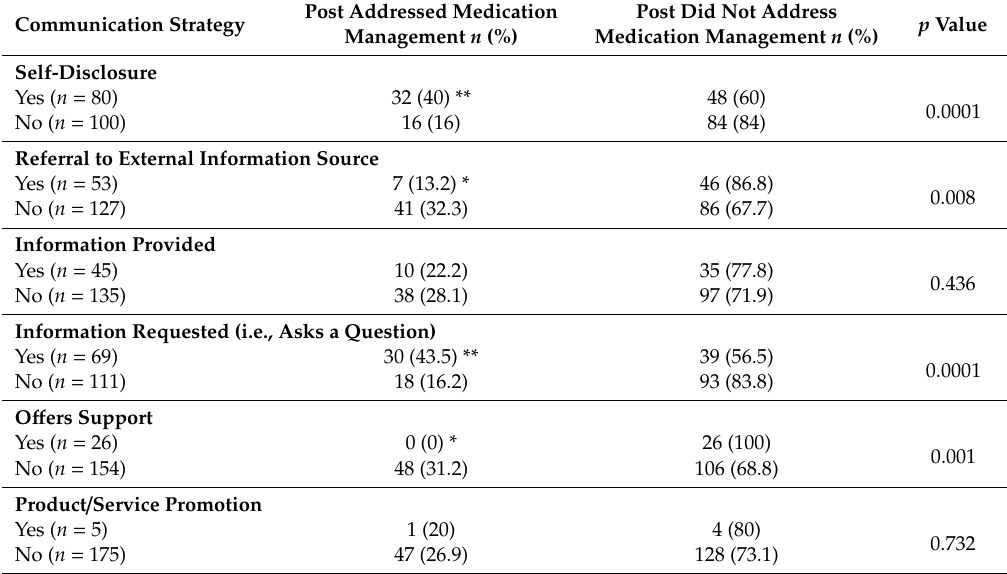
Table 5. Frequency of communication strategies used in COPD Facebook group wall posts according to whether or not post addressed medication management ( n = 48).